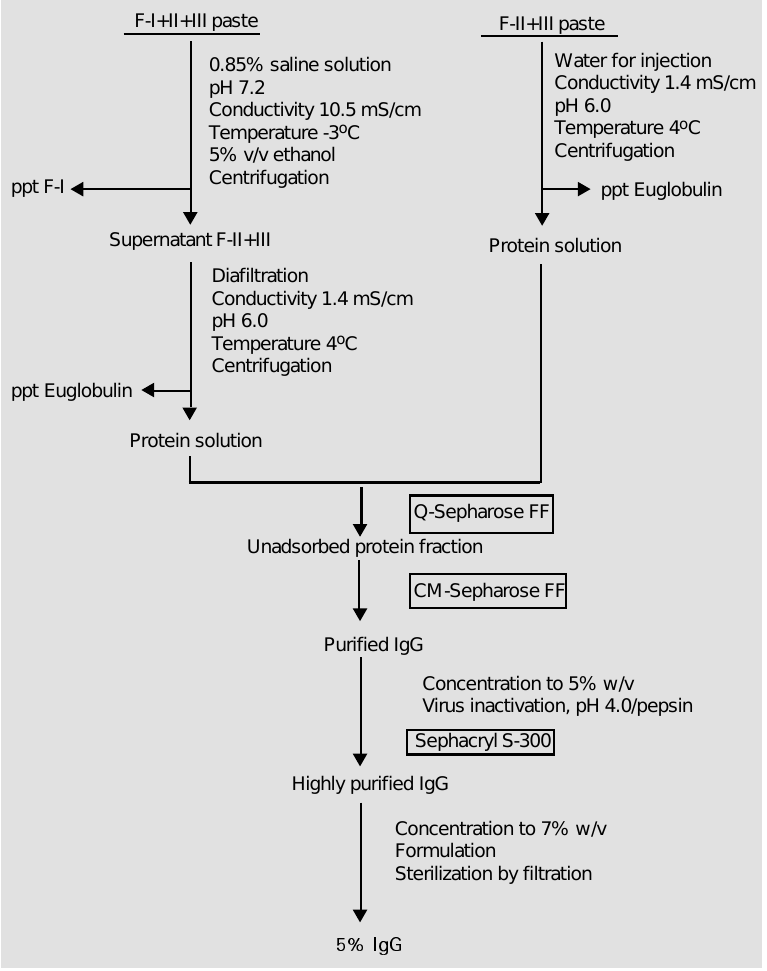
Figure 1 - Flow diagram for the purification of IgG suitable for intravenous